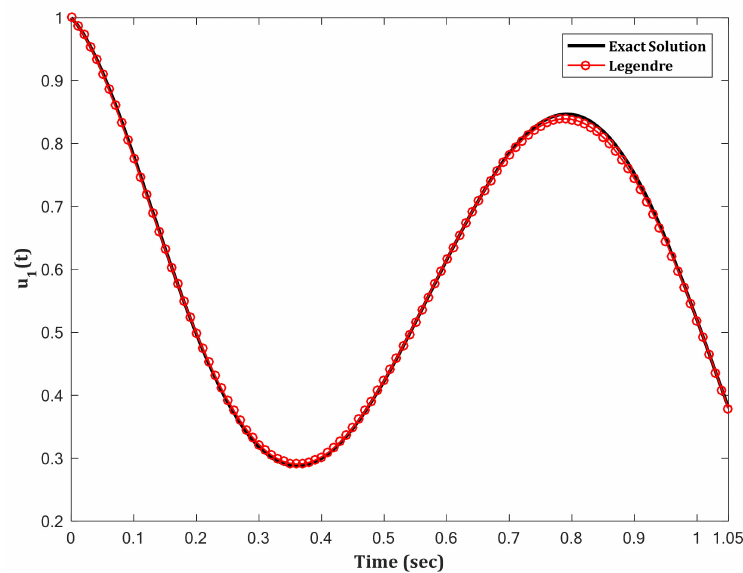
Figure 2. Comparison of LGM and exact solutions for an SDOF